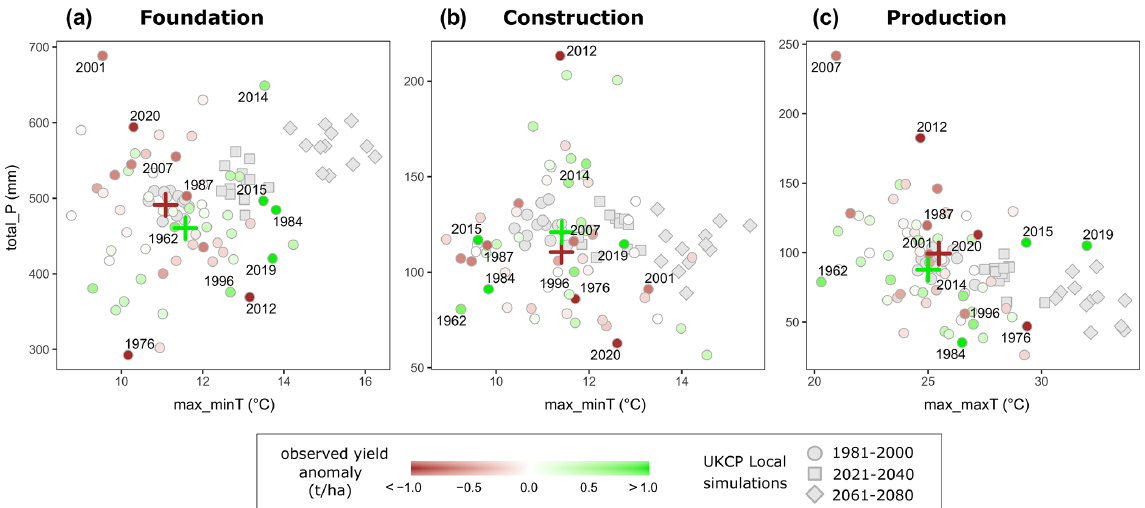
Figure 4. Association between observed wheat yields and climate during the three wheat-growing phases. Anomalies of observed UK wheat yields are shown for total area-averaged precipitation ( total_P ) and the maximum of area-averaged minimum/maximum daily temperature within each phase (i.e. the metrics total_P , max_minT , and max_maxT , chosen for their associations with crop yields; Table 2), alongside UKCP projections. (a) Foundation phase (1 October to 9 April); (b) construction phase (10 April to 10 June); (c) production phase (11 June to 26 July). Yield time series are shown for the national scale here (longer than regional time series; see Fig. 1a vs. Fig. 1b) and are the same in the three panels. Small green circles indicate positive yield anomalies for individual years; small brown circles indicate negative yield anomalies for individual years. Large green crosses indicate the mean for all the years with positive wheat yield anomalies; large brown crosses indicate the mean for all the years with negative wheat yield anomalies. Grey diamonds indicate UKCP Local projections of temperature and precipitation for the historical (circle: 1981–2000) and future (square: 2021–2040; diamond: 2061–2080) periods, where each symbol indicates 1 of the 12 ensemble members. Specific years mentioned in the main text are